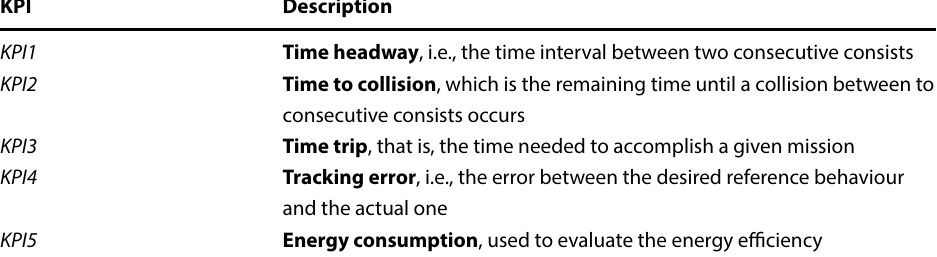
Table 1 KPIs to evaluate the effectiveness of VCTS paradigm